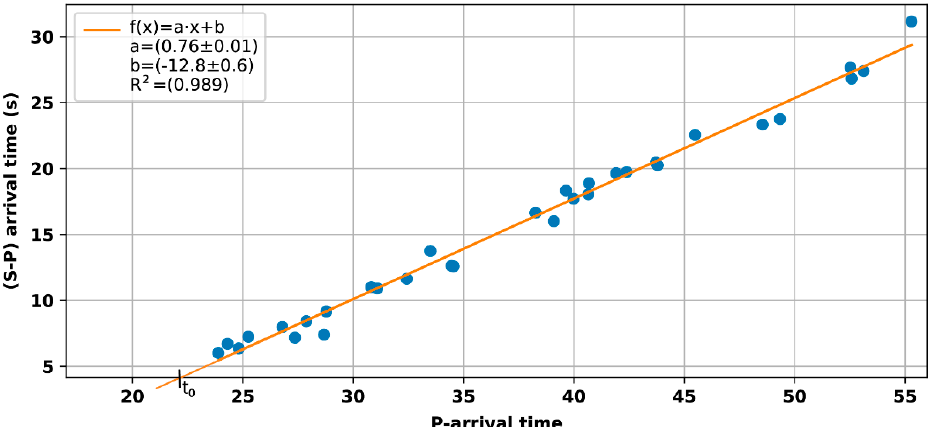
Figure 2. Example of Wadati diagram of a moderate sized (M L = 5.7) earthquake that occurred on 22 November 2014 at the northeastern edge of the Focsani Basin (Marasesti area, see [37]). The slope of the linear fit indicates the correlation of P to S-phase velocities, as a = Vp/Vs − 1. The intersection between the linear fit and P arrival time indicates the origin time of the earthquake (t 0 ).